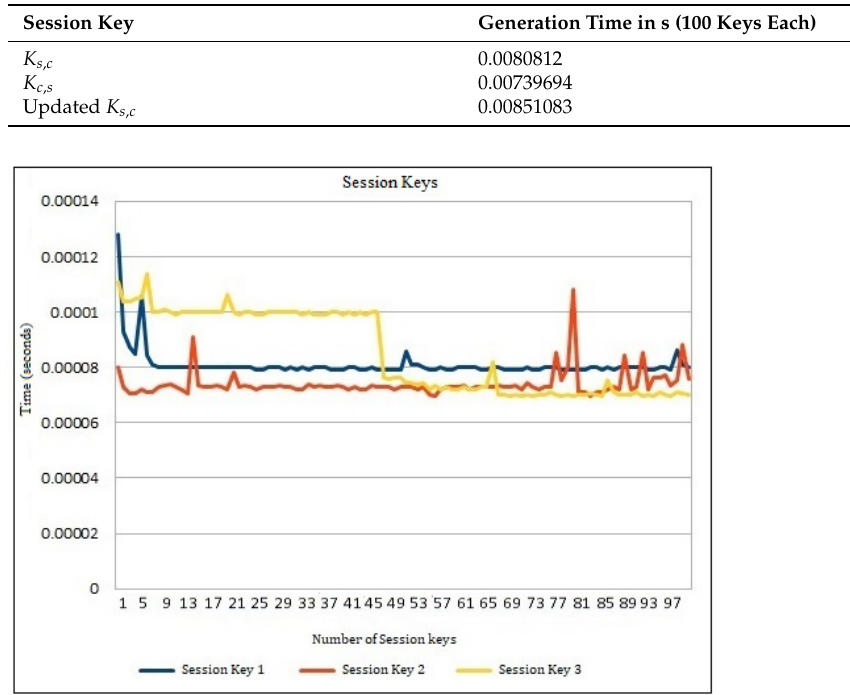
Table 4. Session key performance analysis.